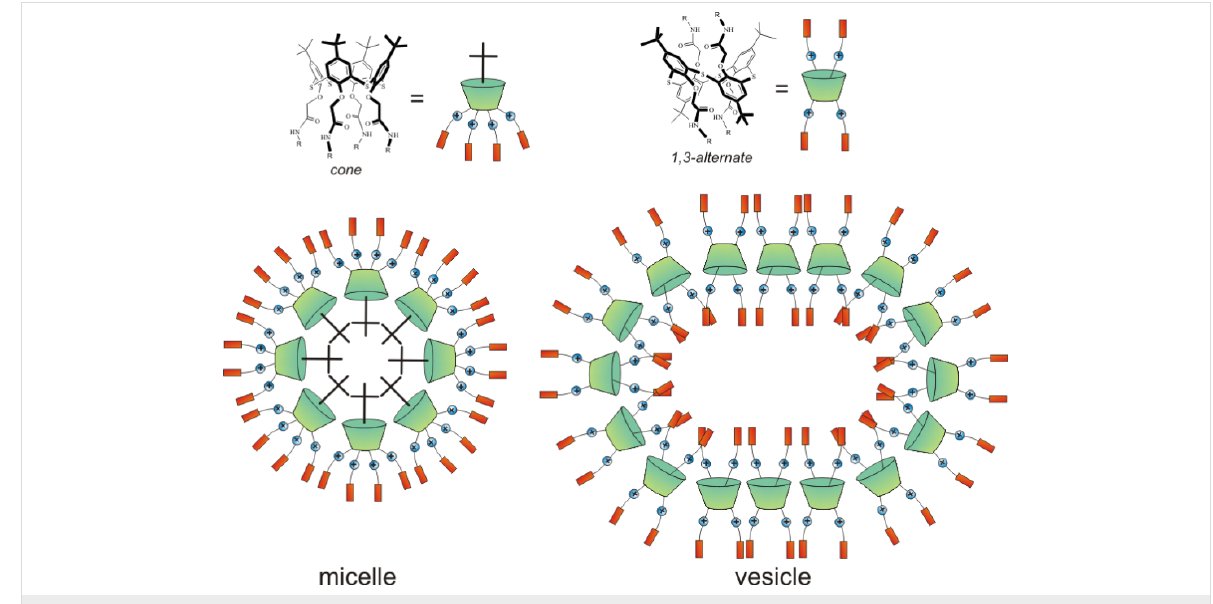
Figure 1: Possible paths of the formation of supramolecular